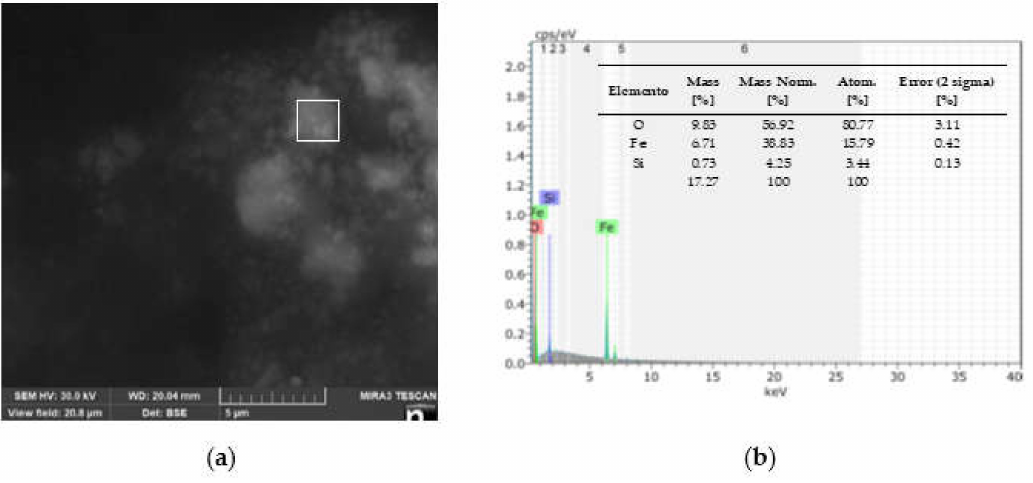
Figure 2. ( a ) SEM image and ( b ) EDS spectrum of MIONPs.